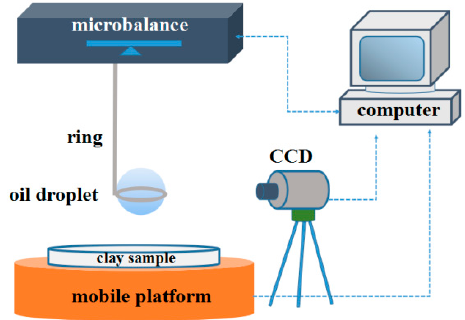
Figure 8. Microbalance experimental setup used during adhesion between oil droplets and